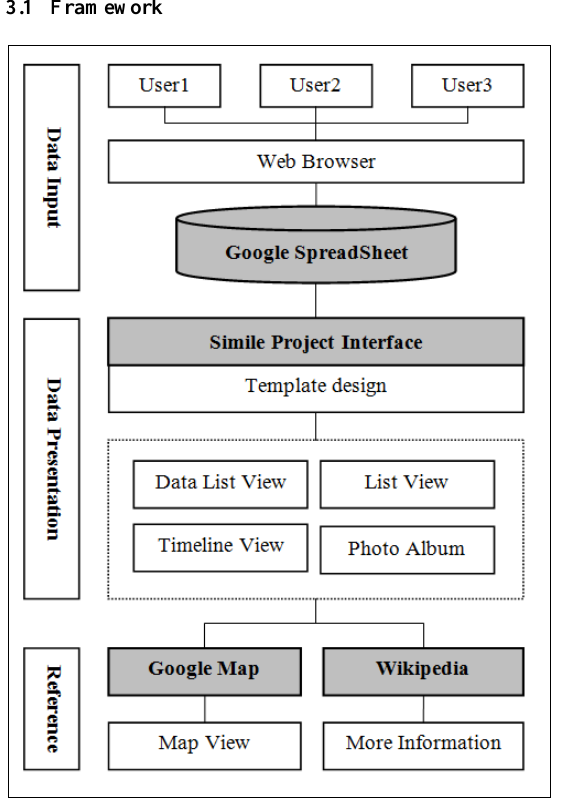
Figure 1. Procedure of information collection and